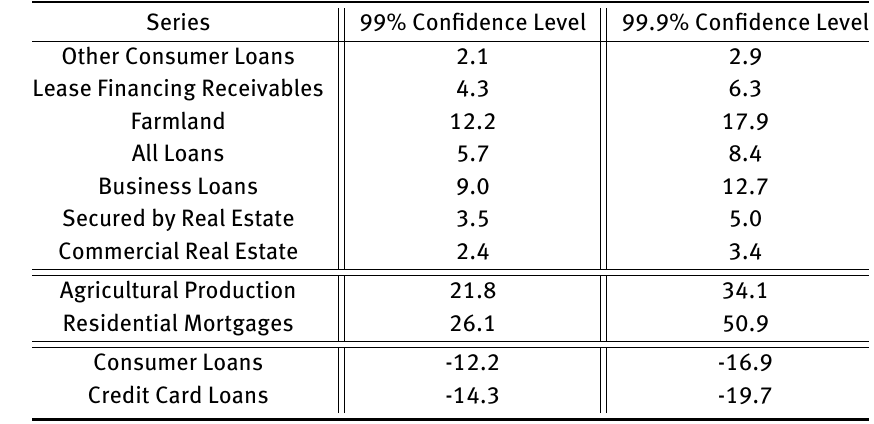
Table 5.4: This table illustrates the relative difference in estimated percentiles between the Vasicek and two-regime state de- pendent models, with parameters as reported in Table 5.3. Specifically it reports ( d sd ( p ) − d v ( p ))/ d v ( p ) , where d v ( p ) is the 100 p th percentile of the fitted Vasicek model (i.e. Vasicek model with parameters as given in Table 5.3 and d sd ( p ) is the 100 p th percentile of the fitted state dependent model with two regimes. Note that d v ( p ) = v x , a ( z 1− p ) , where z 1− p = Φ −1 (1 − p ) and v x , a is the Vasicek curve with parameters as given in Table 5.3, whereas d sd ( p ) must be computed numerically (see Section